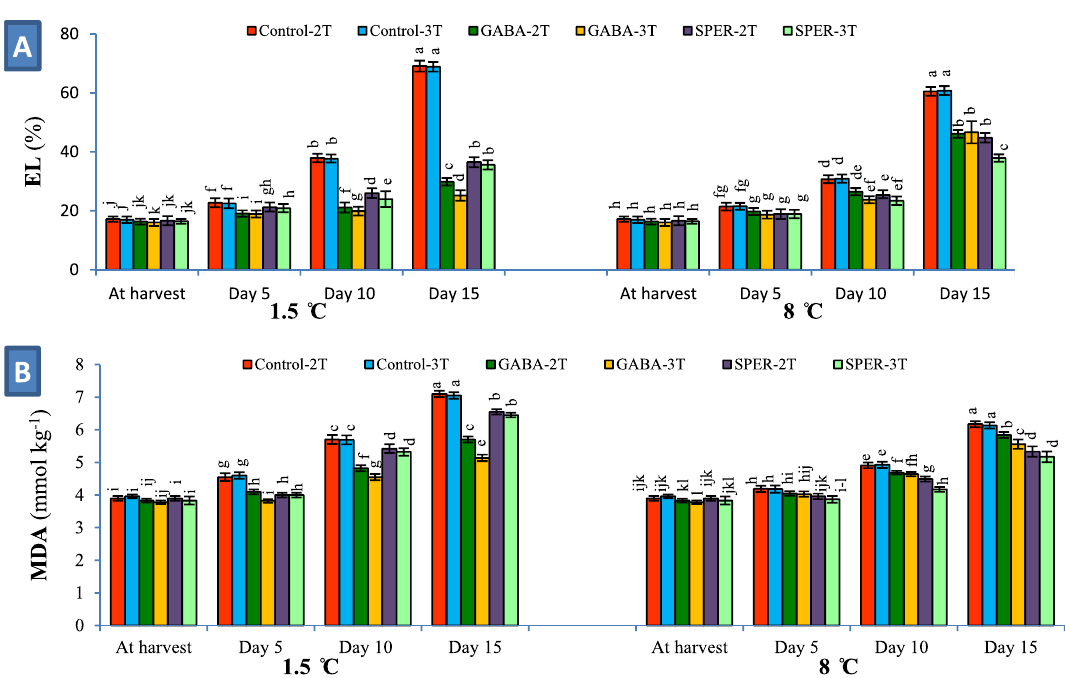
Figure 4. Effect of pre-harvest GABA and SPER spray on the electrolyte leakage (EL) ( A ) and malondialdehyde (MDA) content ( B ) in gerbera ‘Stanza’ cut flowers during cold storage at 1.5 °C and 8 °C. 2 T and 3 T represent number of times the GABA and SPER are sprayed on intact gerbera plants at pre-harvest. Values are mean SE, n = 4. The bars marked with the same letters are not significantly different at p <